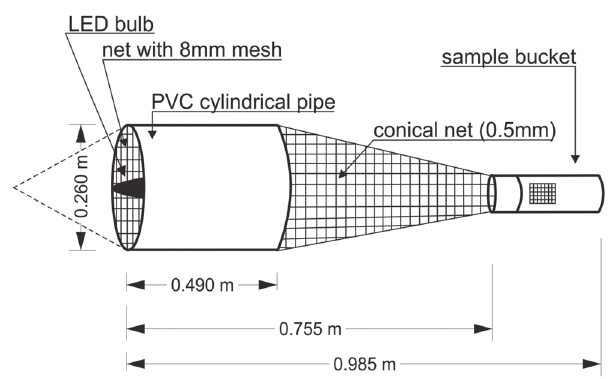
Fig. 2. Light trap used to capture the